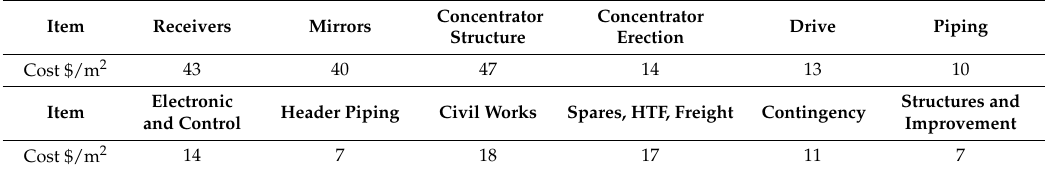
Table 2. The direct capital cost of parabolic trough collector items